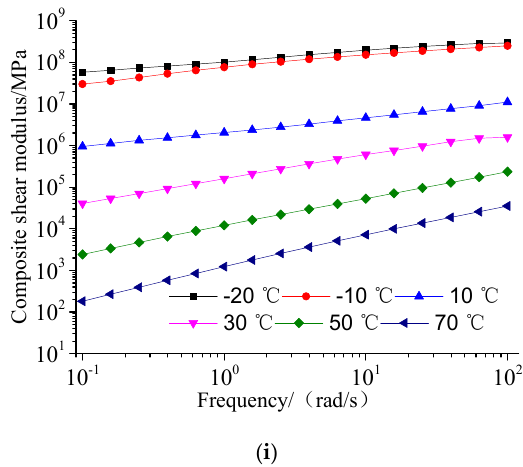
Figure 2. Composite shear modulus of three asphalts with frequency before and after aging: ( a ) SK90 (unaged specimens); ( b ) SK90(thin film oven test (TFOT) specimens); ( c ) SK90 (pressure aging vesse (PAV) specimens); ( d ) Styrene-butadiene-styrene (SBS) (unaged specimens); ( e ) SBS modified asphalt (TFOT specimens); ( f ) SBS modified asphalt(PAV specimens); ( g ) SBS/crumb rubber powder (CRP) modified asphalt (Unaged specimens); ( h ) SBS/CRP modified asphalt (TFOT specimens); ( i ) SBS/CRP modified asphalt (PAV specimens).